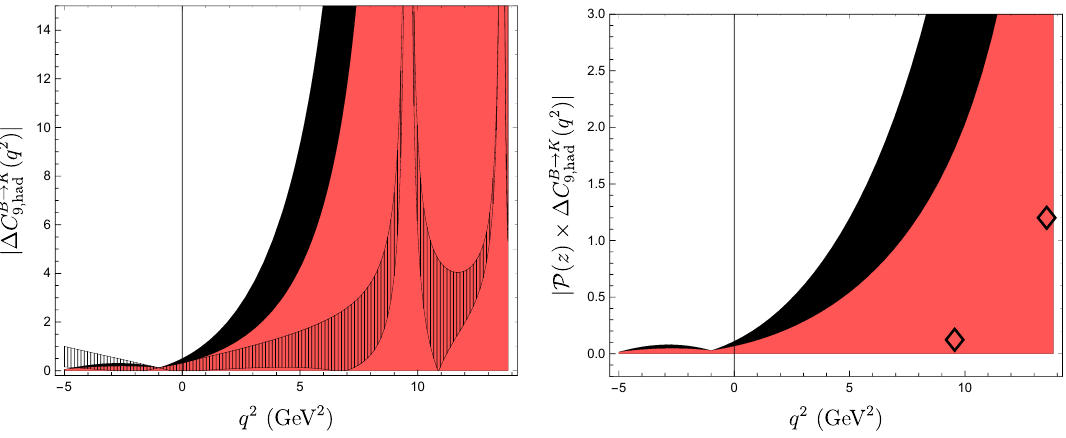
( q 2 ) and the combination 9 , had